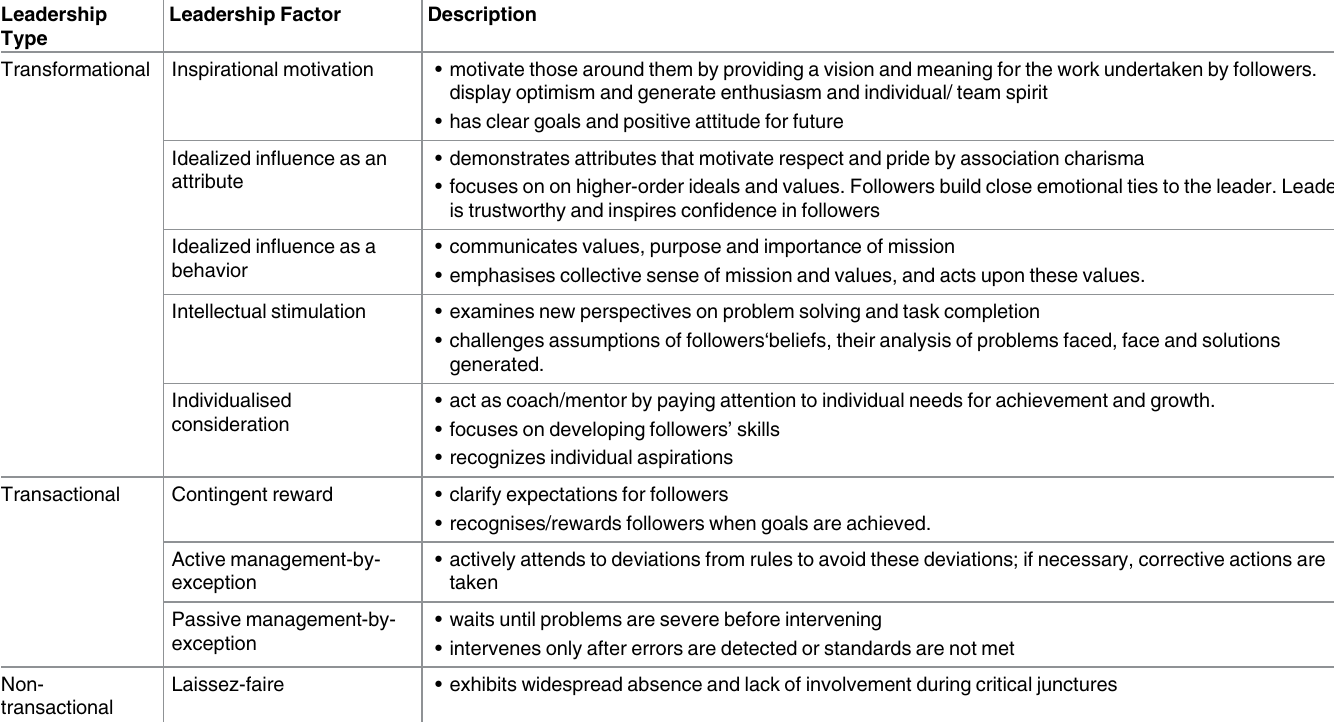
Table 1. Full Range Leadership Model and factor descriptions used for the